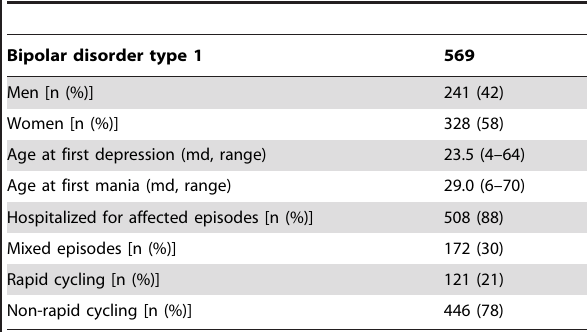
Table 1. Clinical characteristics of the sample set that are genotyped (n=